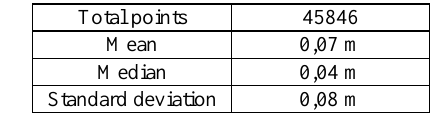
Table 2. Statistics of comparison laser scanning and geodetic measurement.